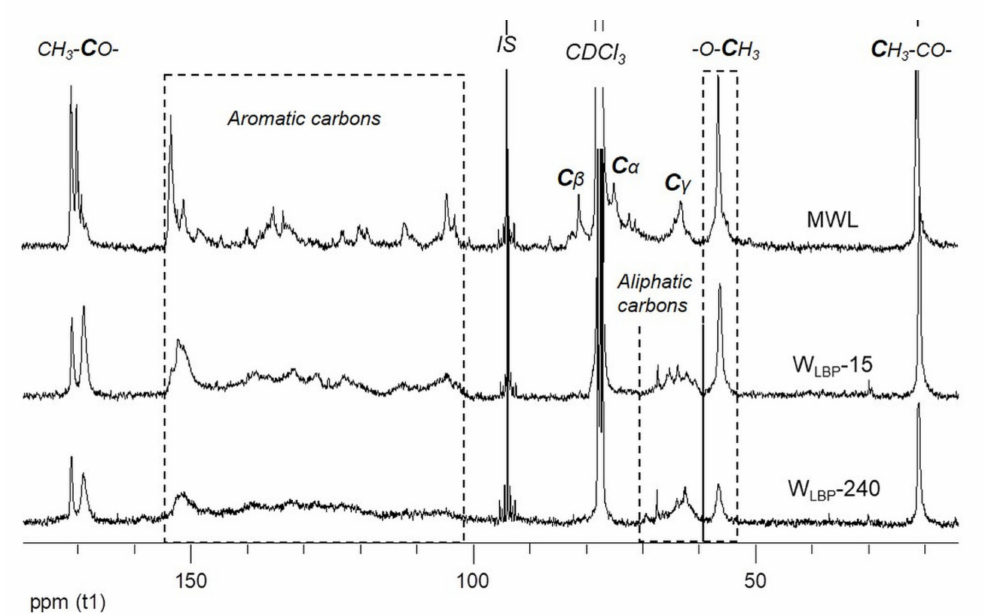
Figure 4. Quantitative 13 C NMR spectra of acetylated MWL, W LBP -15 (15 min of liquefaction treatment) and W LBP -240 (240 min of liquefaction treatment)